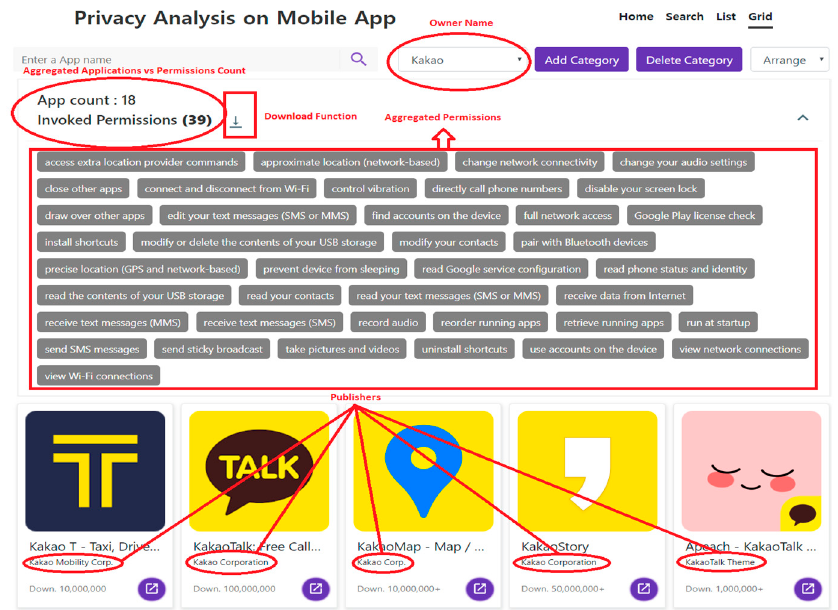
Figure 5. ‘ Privacy analysis on mobile App’ web application (all the apps were owned by Kakao).